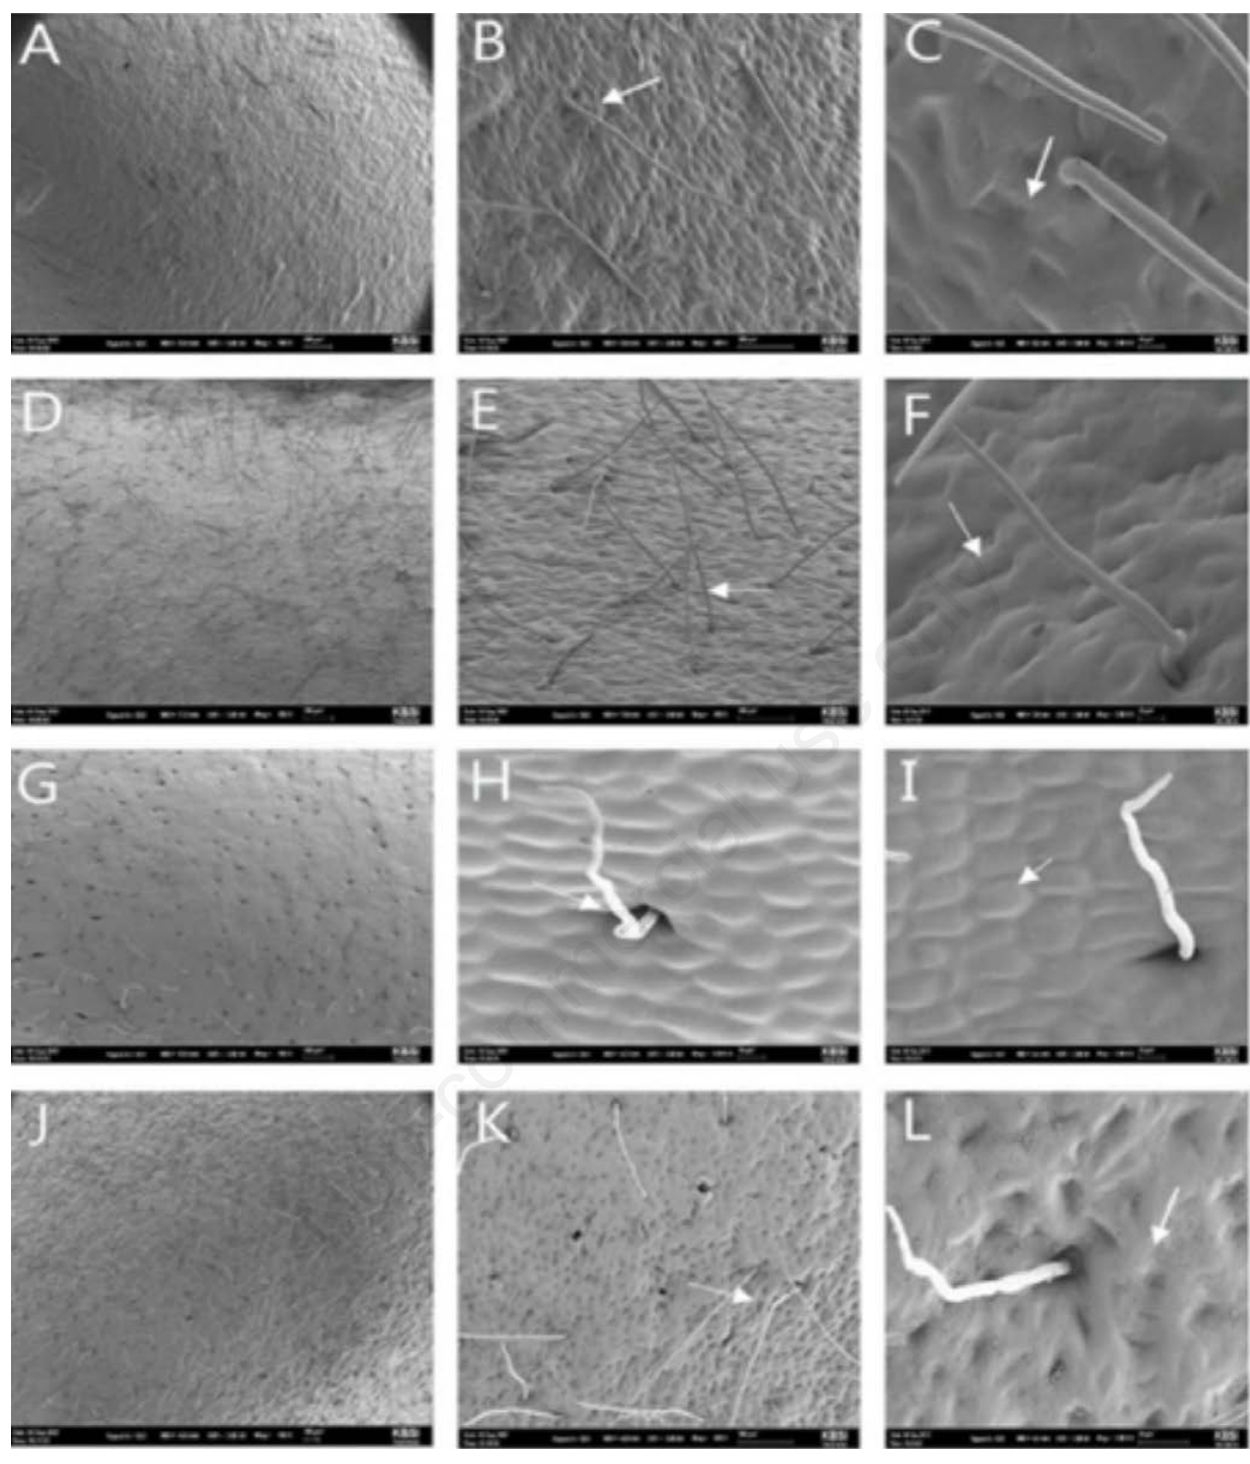
Figure 2. Seed morphology of Calycanthaceae from SEM. A-C, Sinocalycanthus chinensis ; D-F, Calycanthus occidentali s; G-I, Chimonanthus praecox ; J-L, Chimonanthus nitens . (Trichome, E, H, K; Seed surface C, F, I,